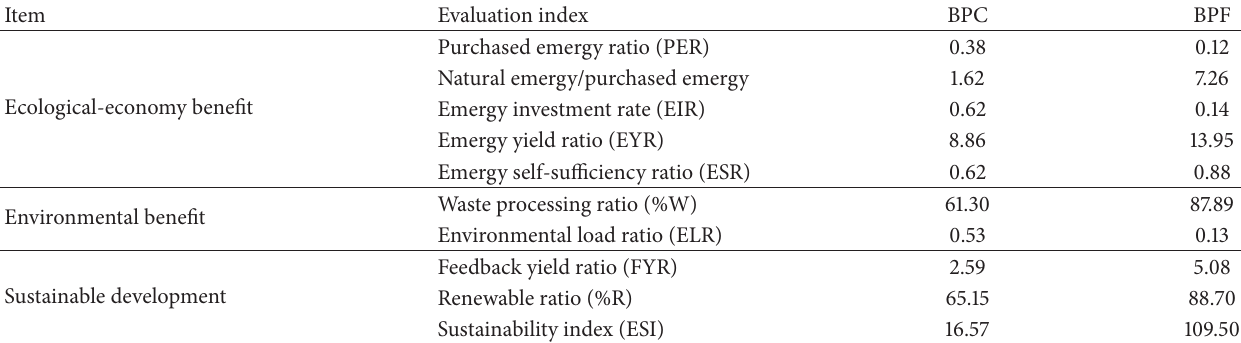
Table 4: The comparative table of energy